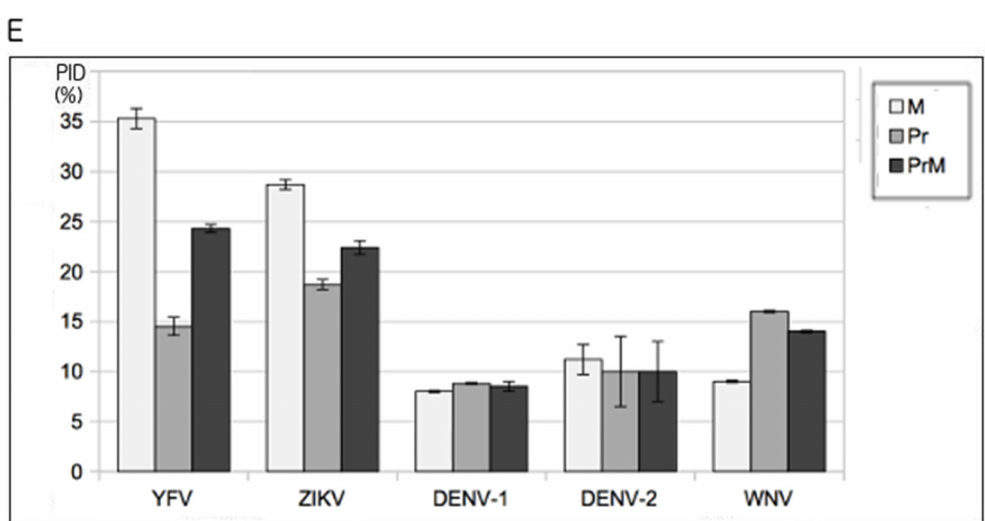
Figure 4. A comparison of M and PrM proteins (membrane and precursor membrane proteins) among the various flaviviruses. ( A ) Three-dimensional structure of the ZIKV M protein, with disordered regions represented in red. ( B ) Cryoelectron microscopy structure of the DENV-2 M protein (with disorder annotation). ( C ) Crystal structure of YFV Pr, with disorder annotated in red. ( D ) Cryo-EM (cryogenic electronic microscopy) structure of ZIKV Pr, with disorder annotated in red. ( E ) A comparison of Pr, M, and PrM among the various flaviviruses. PrM and M proteins protect the immature and mature virions,